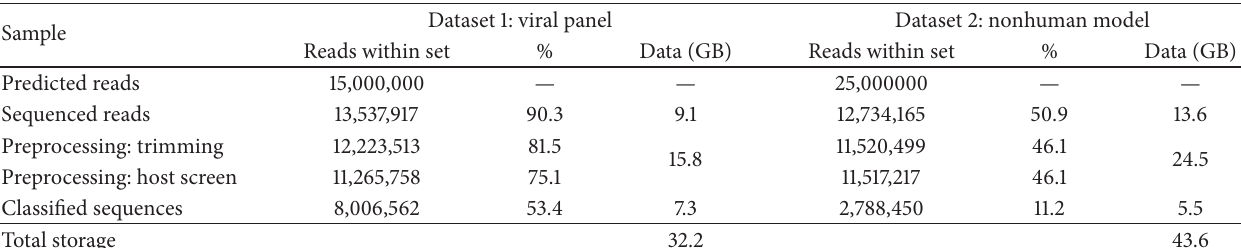
Table 3: Sequence output and data storage for the two datasets. The number of sequences surviving the common preprocessing stages are shown, whilst classified sequences are based on the targeted then assembly approach within the viral dataset, and the kmer based approach within the nonhuman model dataset. Percentages based on the expected number of PE sequences generated for each sequencing chemistry kit used. Storage (in GB) consists of all fastq and intermediate files including bam and bed format files, generated throughout the